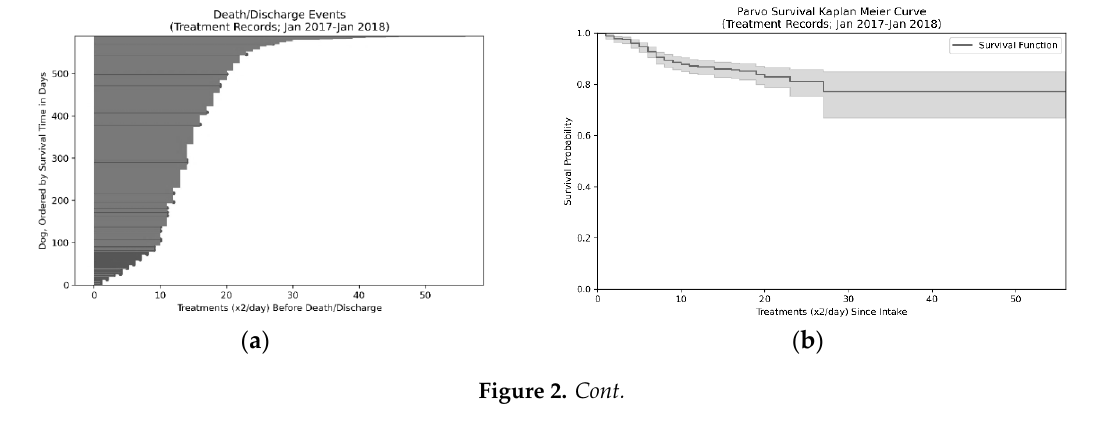
Figure 1. Population values ( a ), survival rates ( b ), and distributional properties ( c ) of canine parvovirus (CPV)-infected dogs from July 2008 to December 2019. The expected survival rates are approximately 86.6% and there is no evidence for a relationship to the overall population occupying the intesive care unit (ICU).